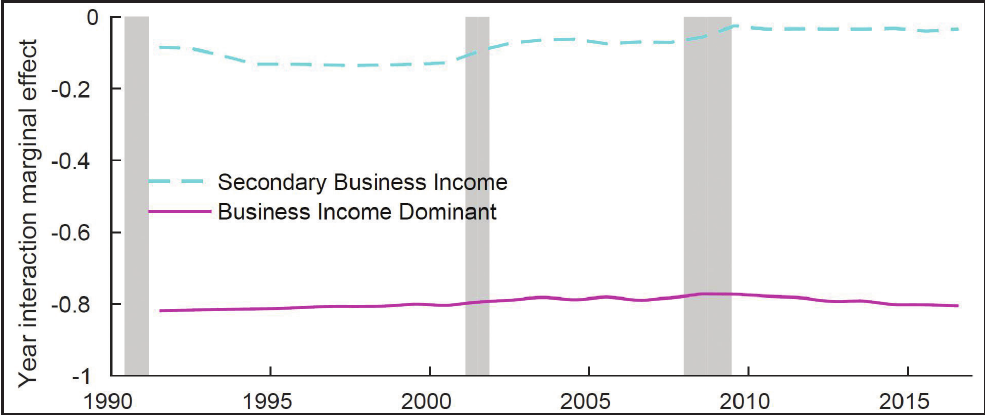
Figure 6 Regression point estimates over